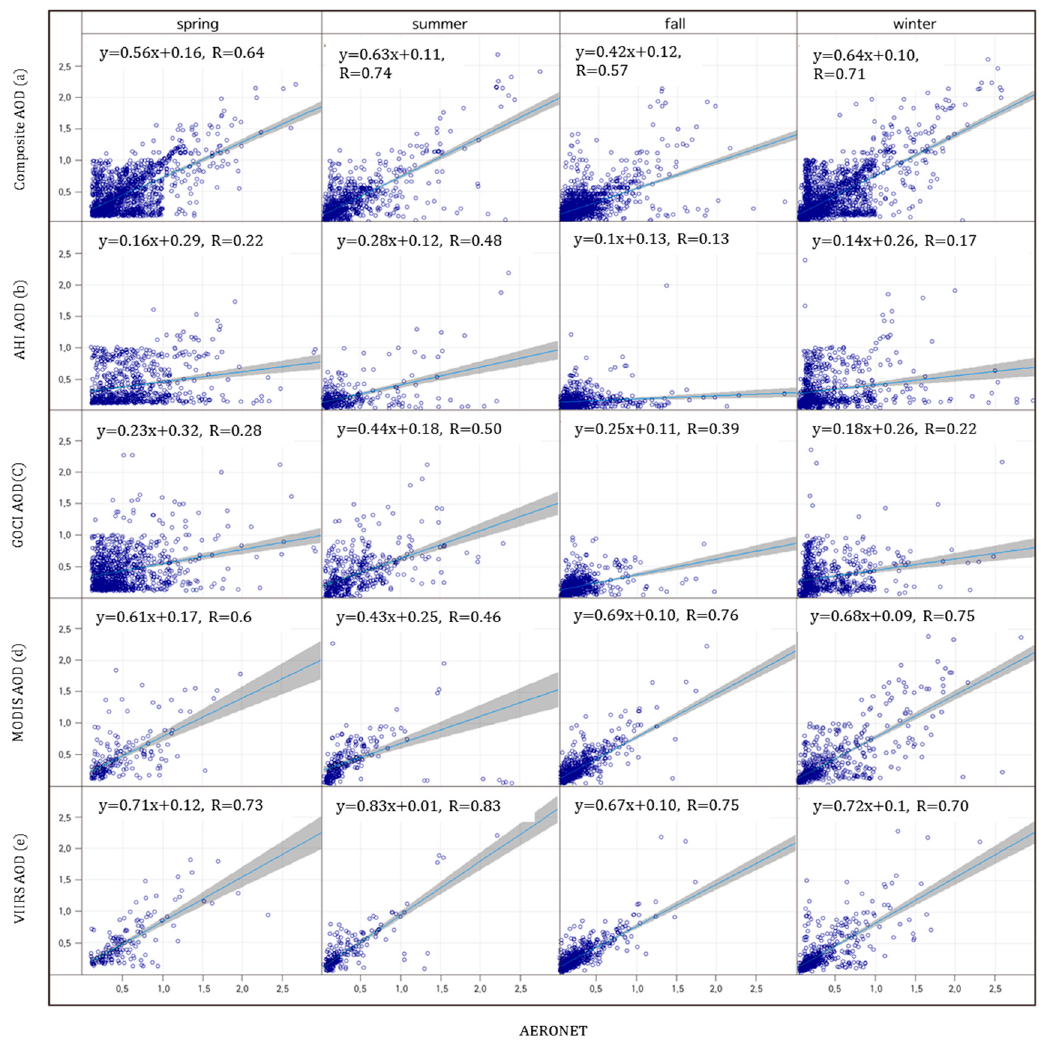
Figure A1. Seasonal comparison between AERONET and satellite AOD values for 2017: ( a ) Composite, ( b ) Himawari- 8/AHI, ( c ) COMS/GOCI, ( d ) Aqua Terra/MODIS, and ( e ) Suomi-NPP/VIIRS. Blue line is the linear regression fit, and gray shading shows the associated error range.